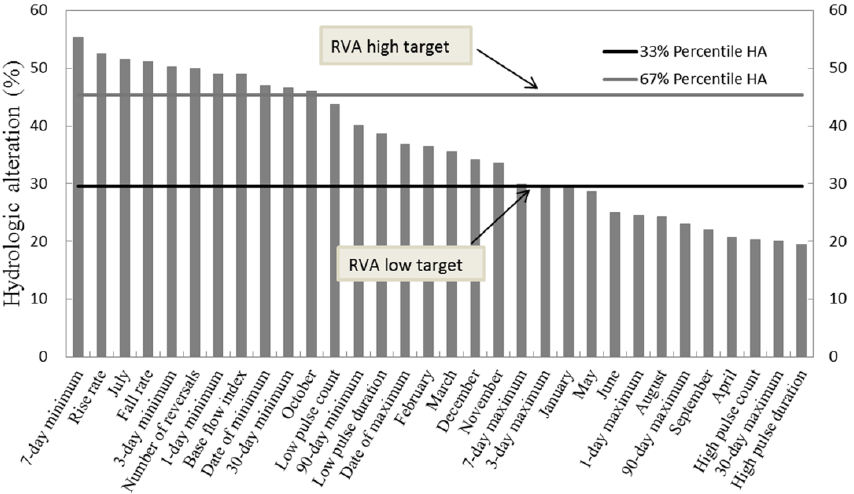
Figure 3. Ranked median absolute degrees and percentile value of 32 indicators of hydrologic alteration for seven hydrological stations in the middle and lower Yangtze